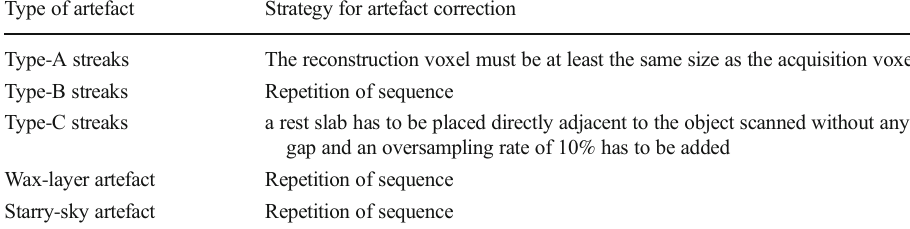
Table 3 Strategies for correction of different artefact types Type of artefact Strategy for artefact